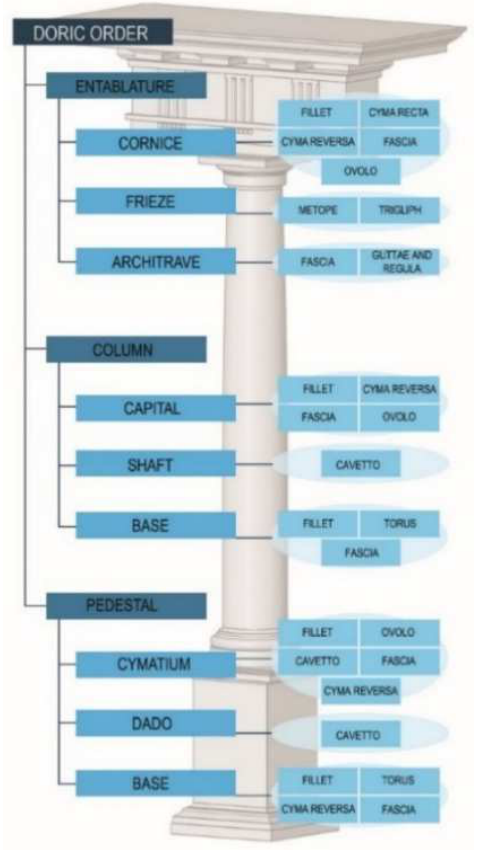
Figure 1. Formal structuring of Doric Order,